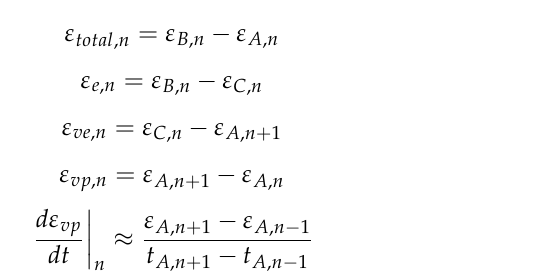
where t is the time period, n is the analyzed loading cycle, N is the total loading cycle, which is 50 in the example shown in Figure 4c, ε total , n is the total strain in the n th cycle, ε e , n is the elastic strain (or instantly recoverable) part of ε total , n , ε ve , n and ε vp , n are the viscoelastic strain (or delayed recovered strain) and viscoplastic strain (or residual strain) (cid:12) d ε vp (cid:12) part, respectively, and is the mean RPS in these n cycles. (cid:12) dt n The average value of each index in the last 10 cycles was calculated for analysis. In addition, the stiffness and RLSLS of each type of HMA can be further calculated with Equations (15) and (16),